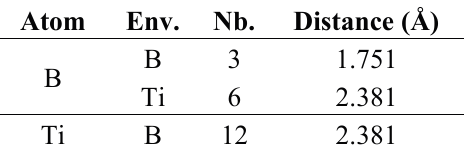
Table 4. Environment of the TM and B atoms in the hP3